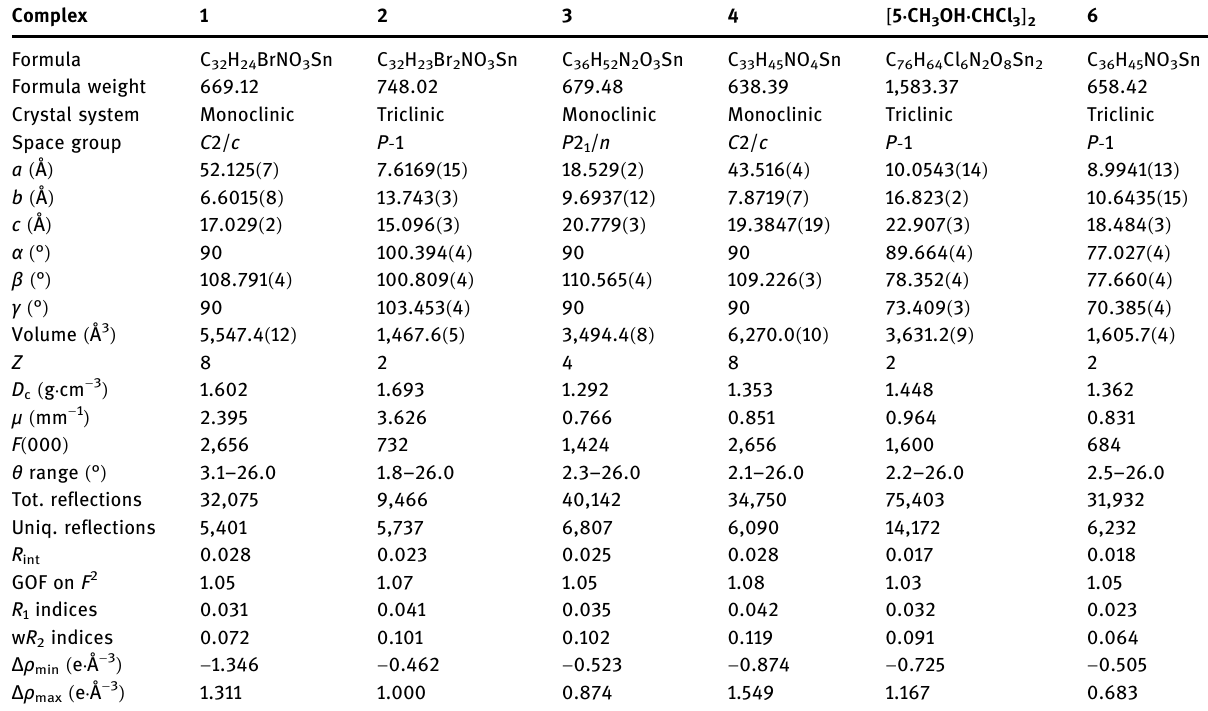
Table 5: Crystallographic and re fi nement data for the complexes Complex